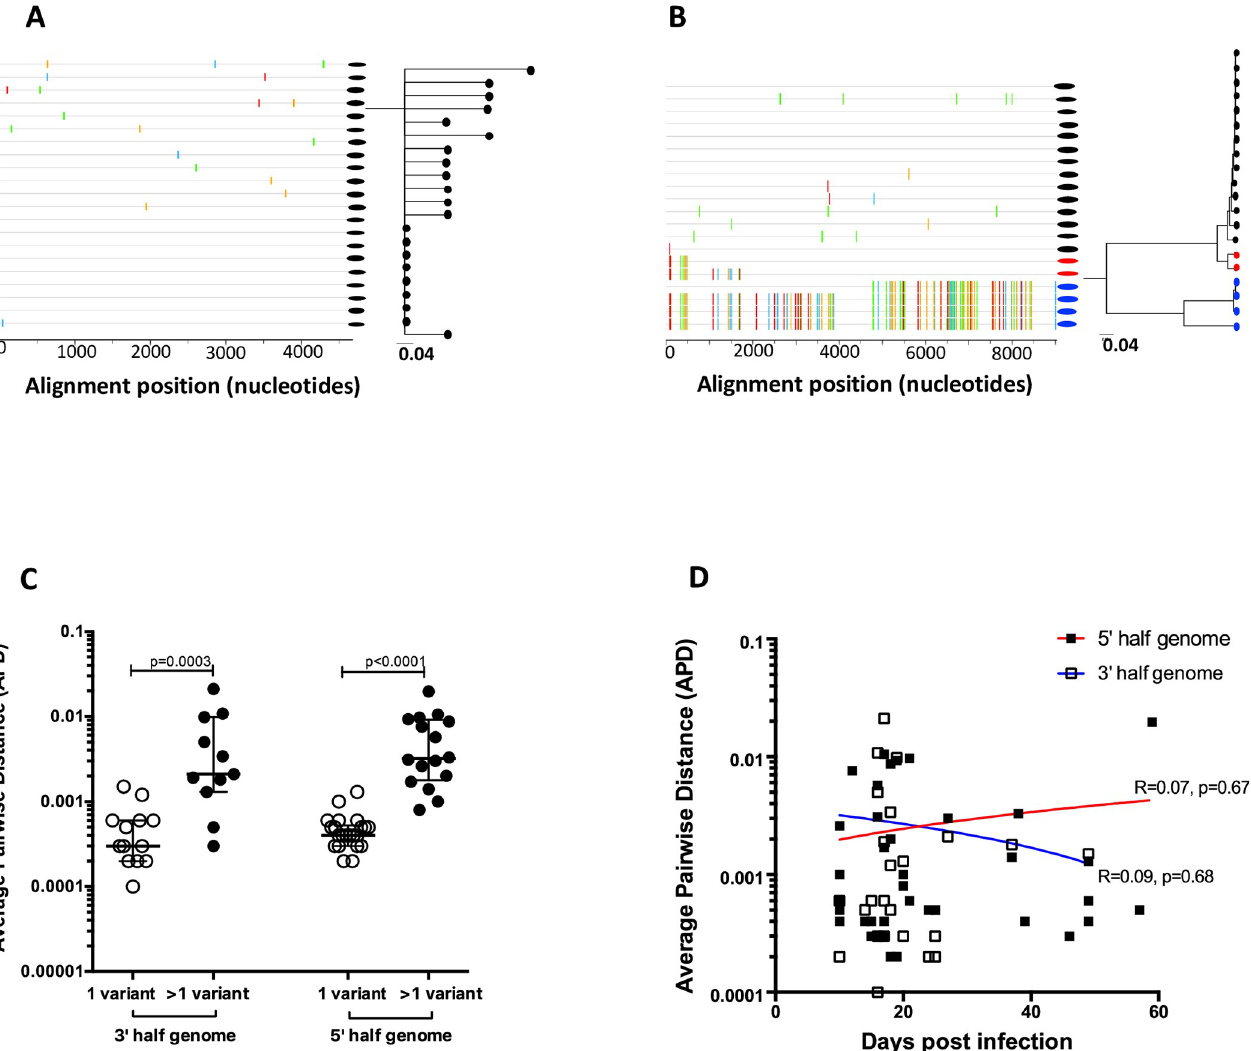
Fig 1. A and B) Highlighter plots and ML branches of single variant and multivariant infection respectively. Two distinct variants are denoted in black and blue while inter-variant recombination is denoted in red on Fig 1B. C) Average pairwise distance (APD) of HIV-1 SGA/S sequences distinguishes between single and multiple founder variants. D) Average pairwise distance (APD) plotted against days post infection showing no evidence for increased diversification and confirming that samples in this time window were close to the wild type transmitted/founder